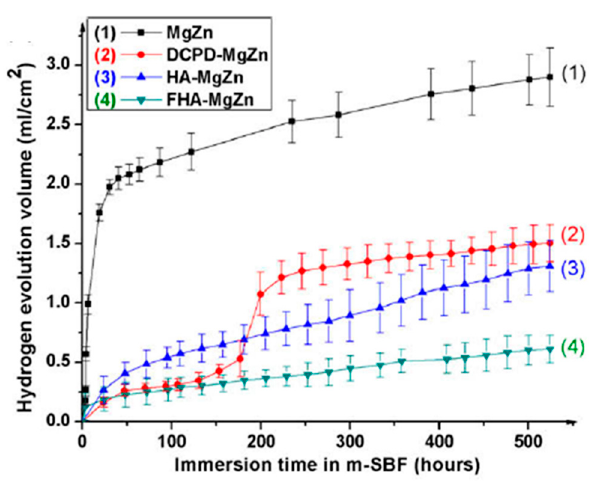
Figure 35. Hydrogen evolution of Mg-Zn alloys with and without Ca-P coatings in m-SBF. Reproduced with permission from [167], Elsevier, 2010.